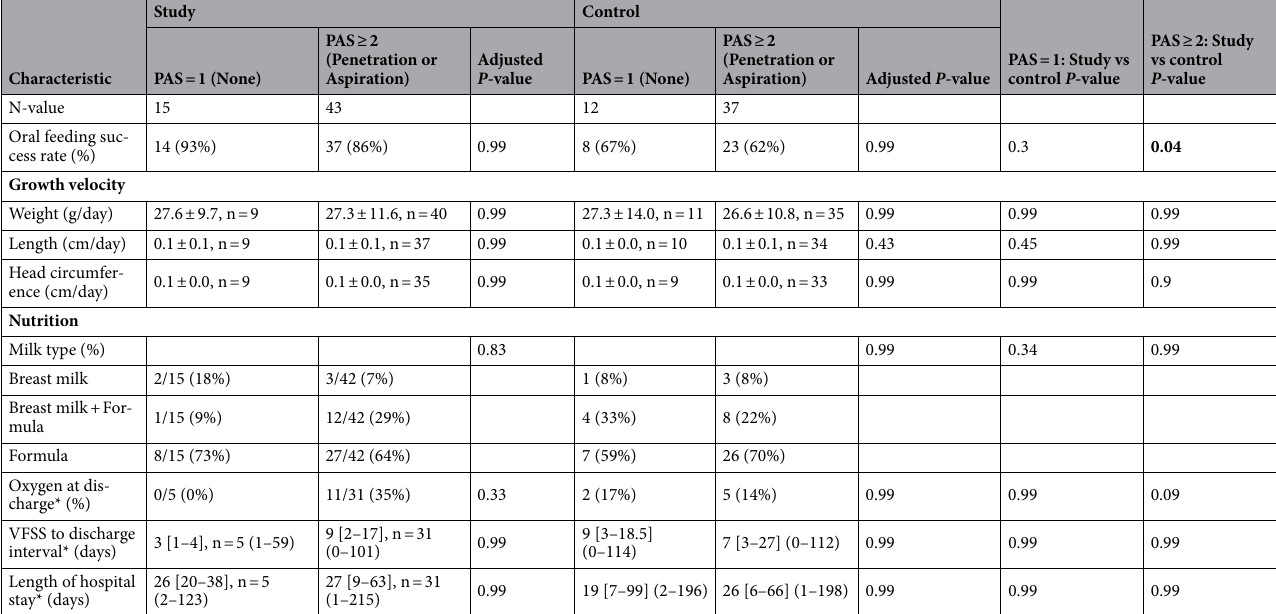
Table 3. Comparison of Clinical Outcomes within and between Study vs. Control Cohorts with and without Penetration or Aspiration. Data presented as n (%), mean ± SE, median [IQR], and (min, max). VFSS: